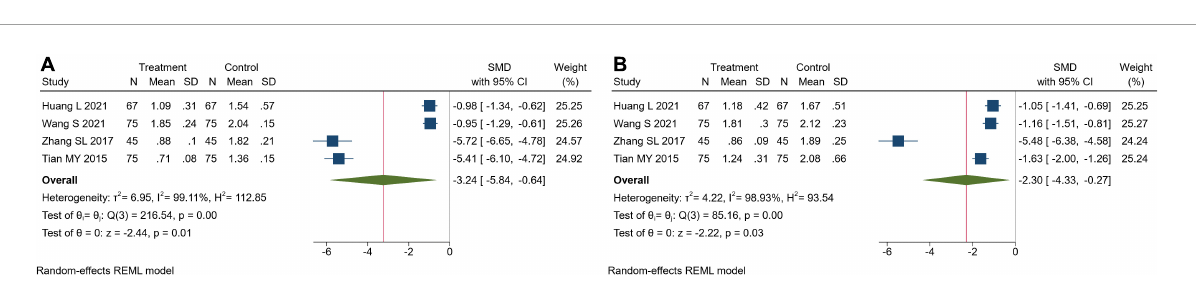
FIGURE7 Forest plot of TCM symptoms. (A) Headache dizziness; (B) soreness and weakness of waist and